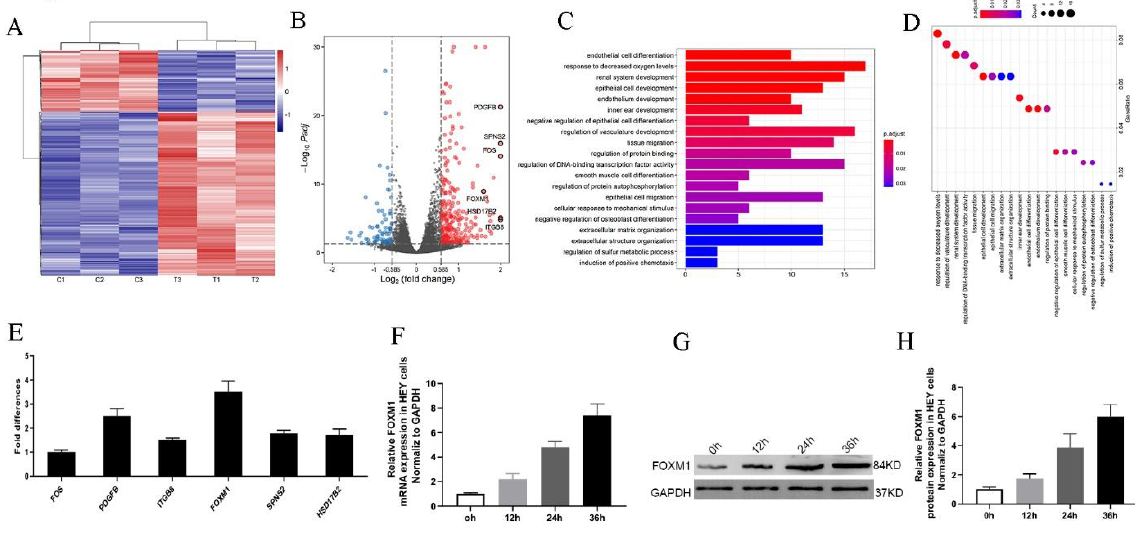
Figure 4. Transcriptome analysis of HEY cells treated with HO-ADSC exosomes. ( A ). Heatmap showing differentially expressed genes in HO-ADSC exosome-treated HEY cells and HEY control cells. ( B ). Volcano map showing the upregulated and downregulated genes from HO-ADSC exosome-treated HEY cells and HEY control cells. ( C , D ). Bioinformatics analysis was performed to determine clusters of differentially expressed genes with enriched molecular functions. ( E ). qRT–PCR experiments were performed to detect the expression of the top 6 upregulated mRNAs. ( F ). FOXM1 mRNA expression was measured by qRTPCR after treatment with HO-ADSC exosomes for 0, 12, 24, and 36 h. ( G ). Western blotting was performed to evaluate FOXM1 expression after treatment with HO-ADSC exosomes for 0, 12, 24, and 36 h. ( H ). Quantitative analysis of FOXM1 protein levels in HEY